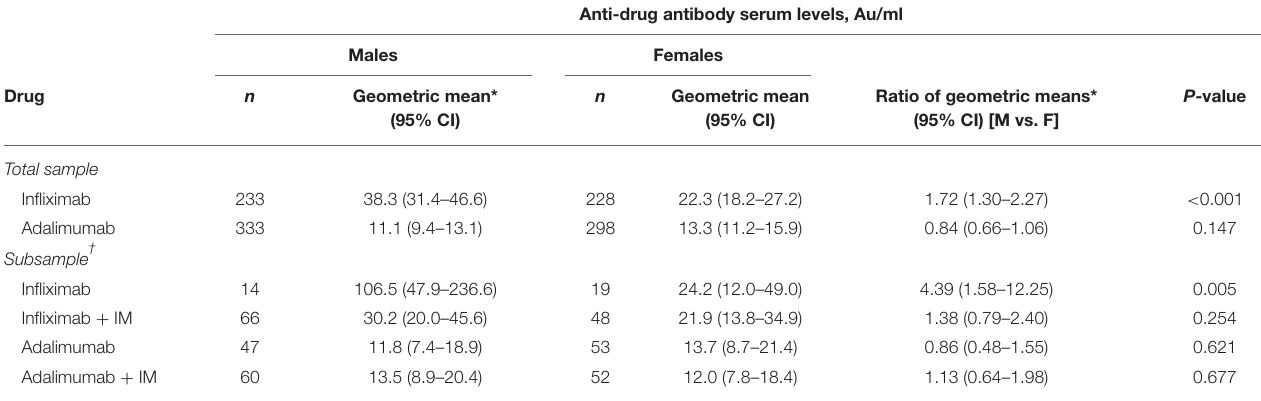
TABLE 2 | Anti-drug antibody serum levels stratified by sex according to monotherapy and combination therapy for infliximab and adalimumab use: inter-sex comparisons. Anti-drug antibody serum levels, Au/ml Males